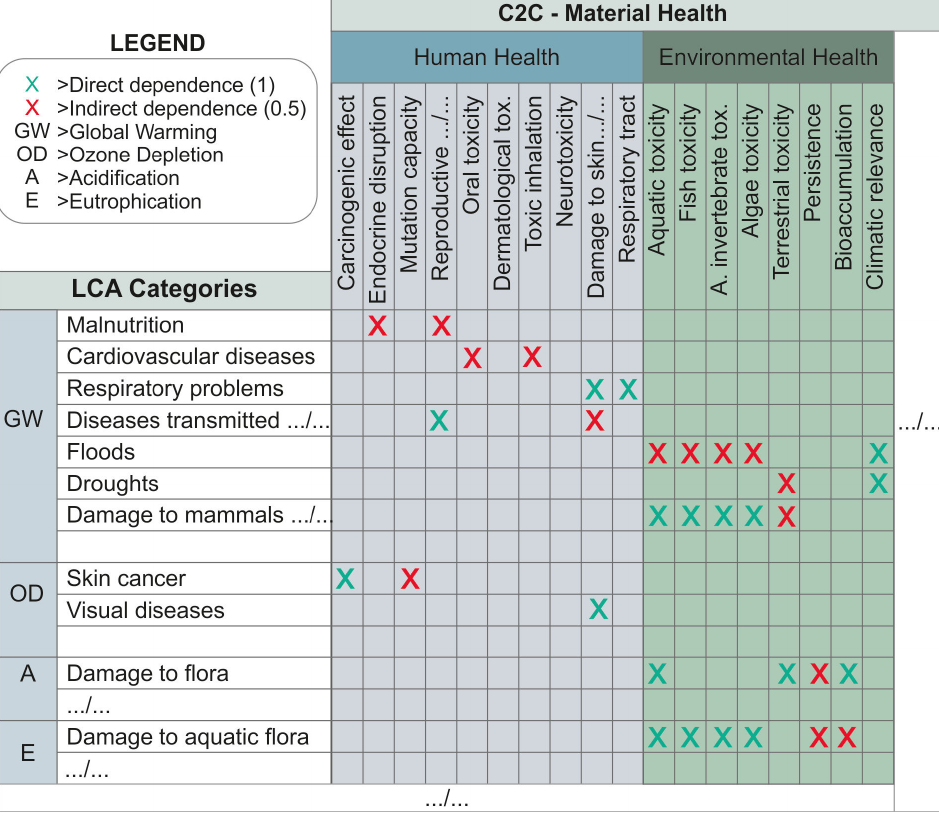
Figure 2. Relationship process between C2C and LCA